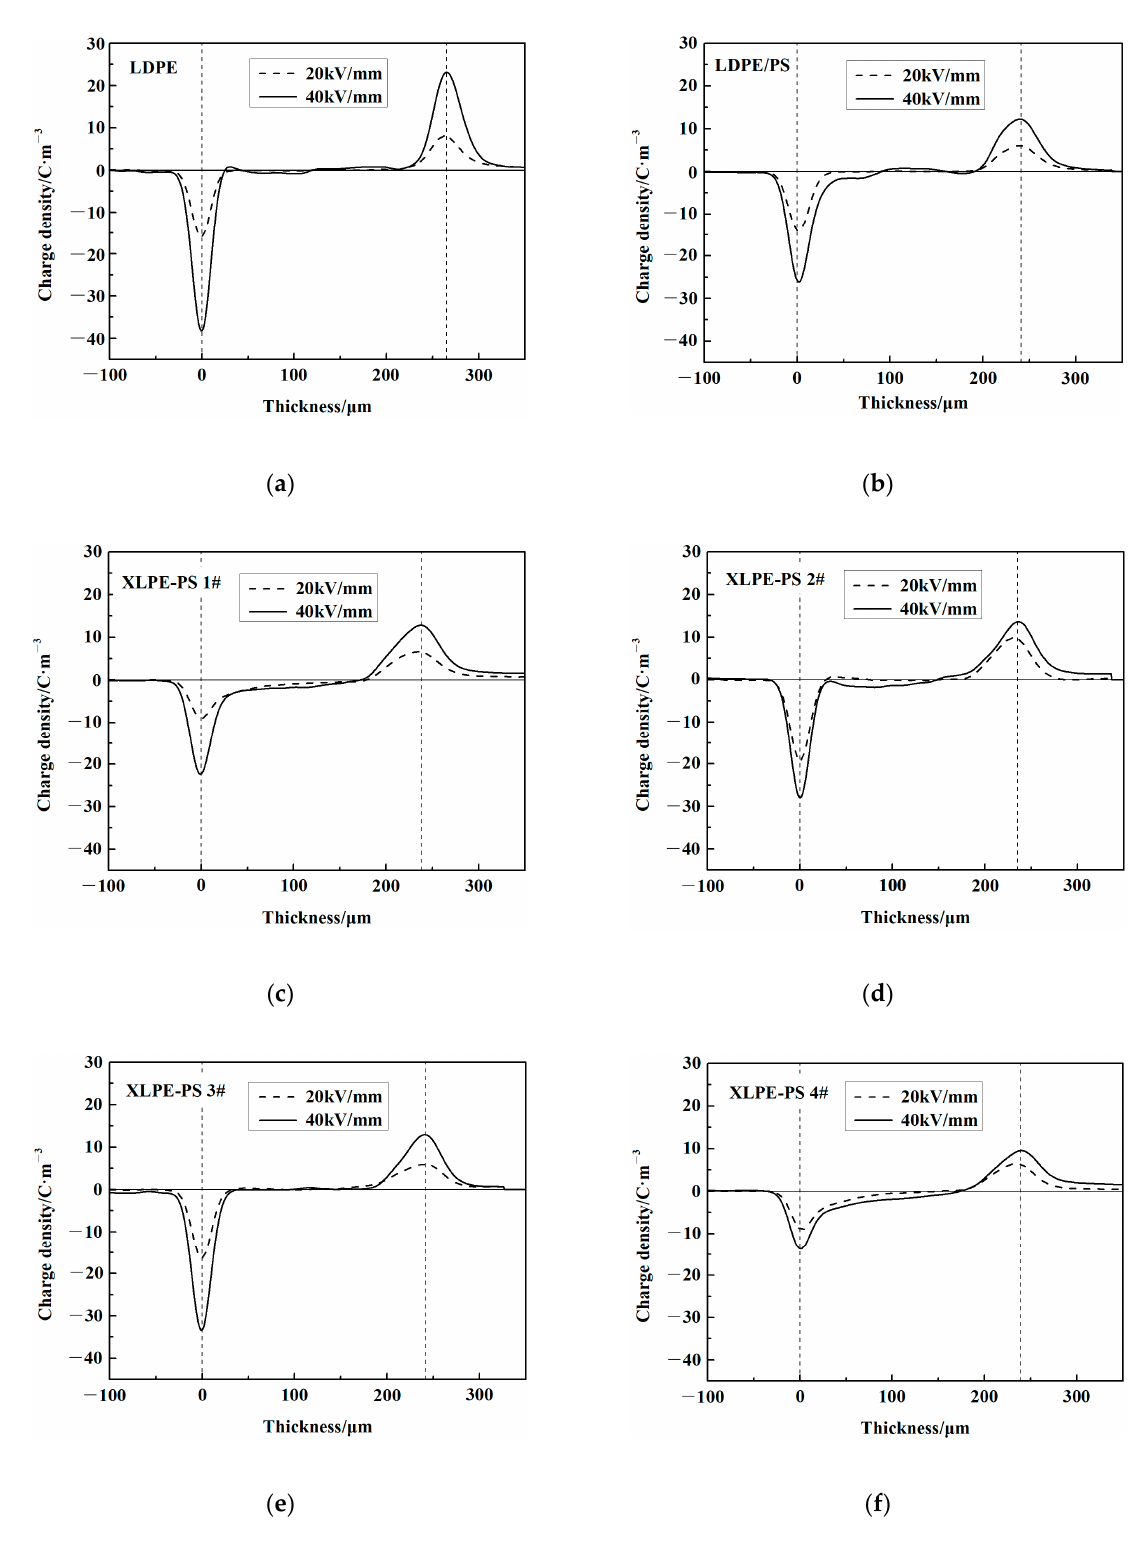
Figure 4. Space charge distribution in: ( a ) LDPE; ( b ) LDPE/PS; ( c ) XLPE-PS 1#; ( d ) XLPE-PS 2#; ( e ) XLPE-PS 3#; ( f ) XLPE-PS 4#.